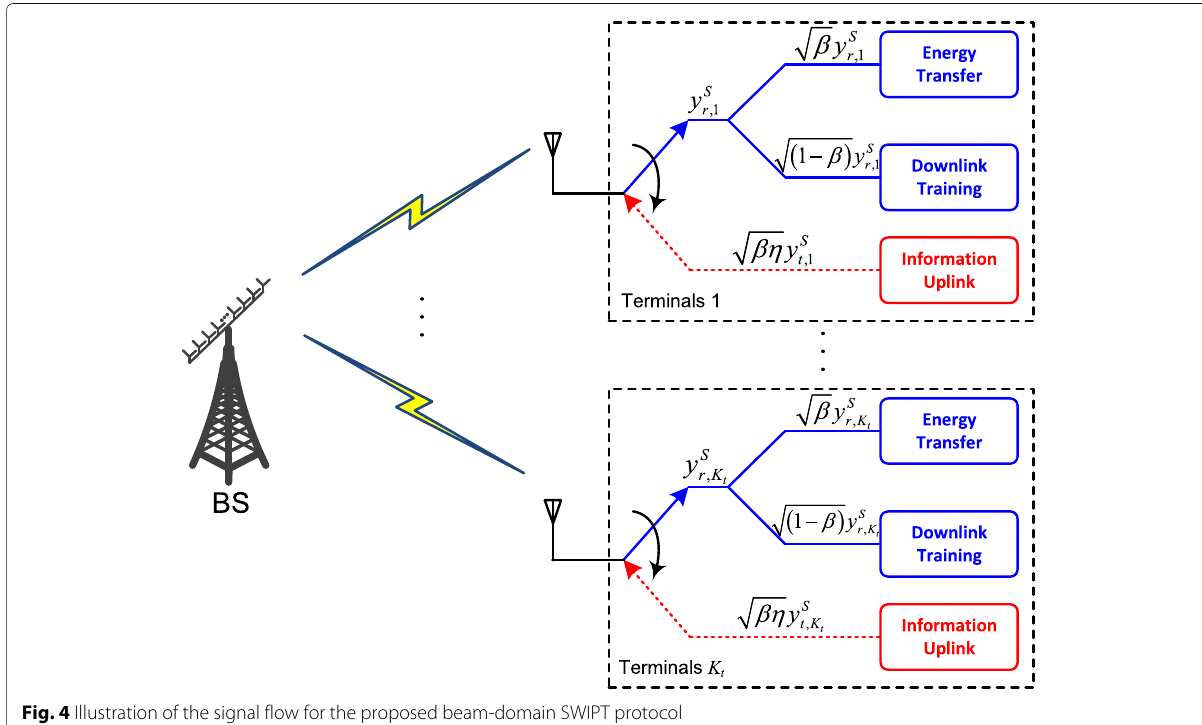
energy sequence and satisfies τ t ≥ b g